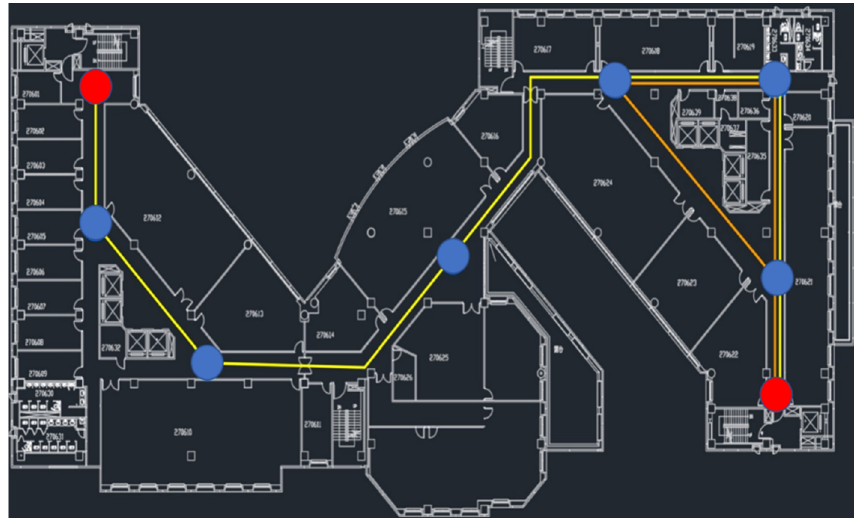
Figure 2. Building map and test route.